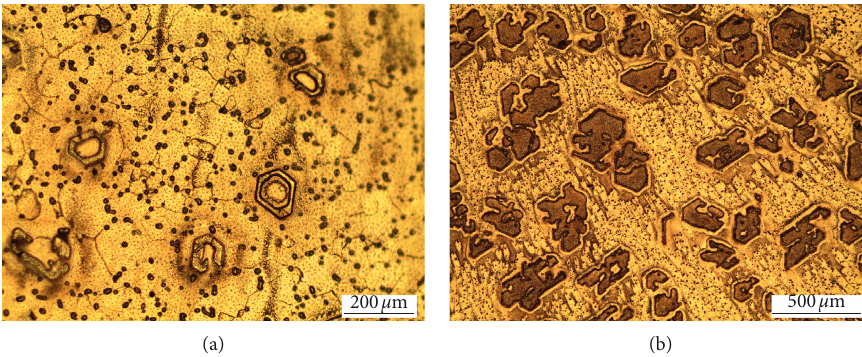
Figure 3: Transverse sections of samples grown at (a) V � 0.5 µ m/s and (b) V � 2.0 µ m/s and G